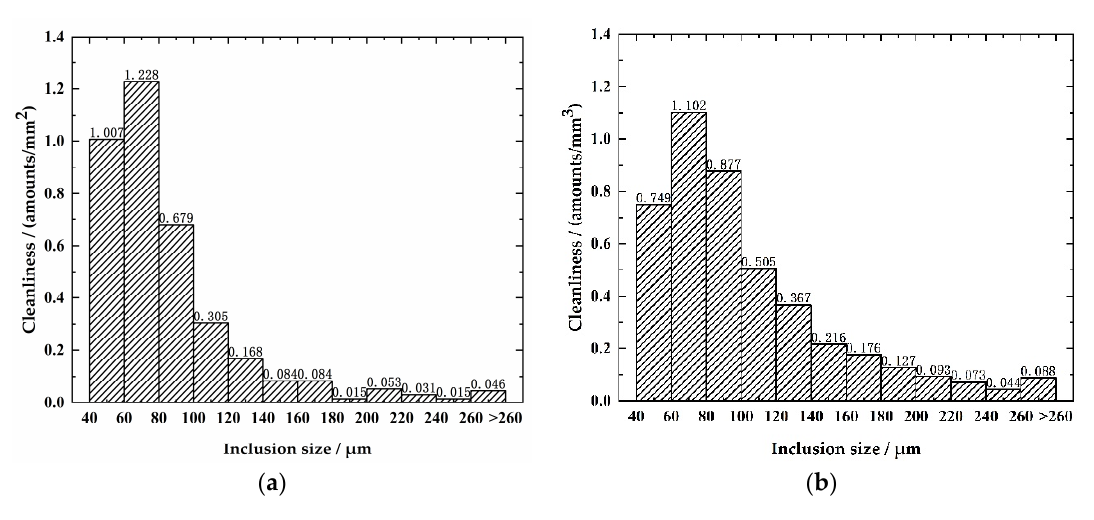
Table 3. Proportion of inclusions area by different methods.